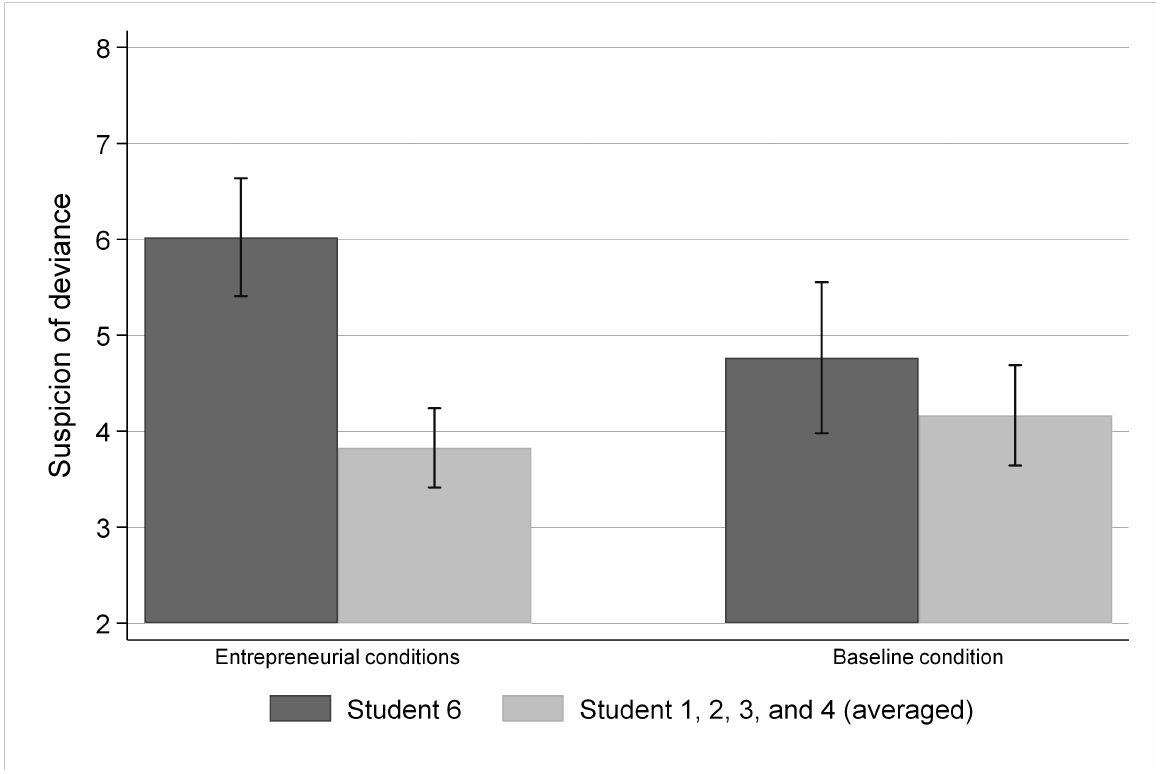
Figure 2: Within-subject comparisons of likelihood that the student in question changed his response in the High-Accusability/Entrepreneurial conditions and the High-Accusability/Baseline condition in study 1. The error bars indicate the 95 percent confidence interval. Possible values of the y axis range from 1 (very unlikely) to 10 (very likely). Separate measures for students 1, 2, 3, and 4 were averaged in all the High- Accusability/Entrepreneurial conditions and the High-Accusability/Baseline condition (Cronbach’s alpha = 0.96). The measure is the response to the following question: “How likely is it that student X wrote the